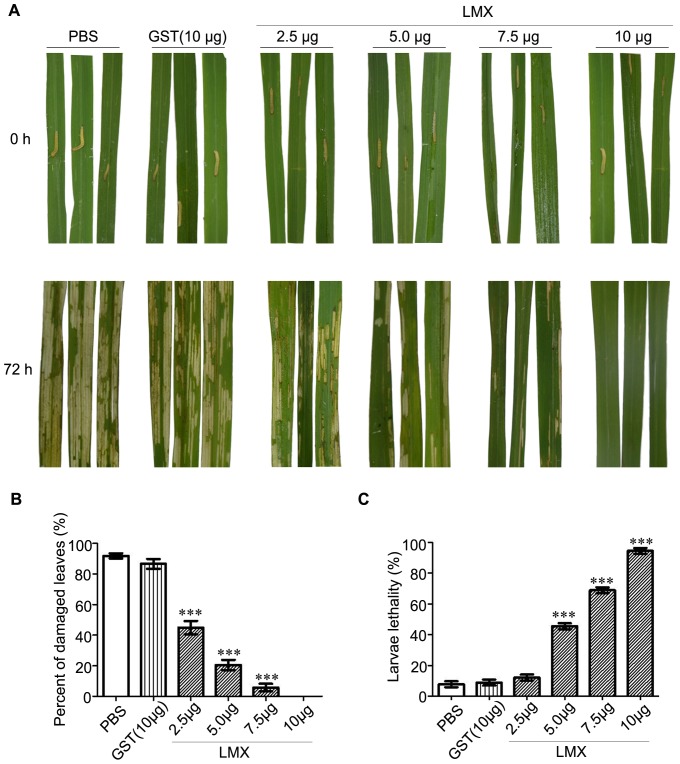
The LMX protein confers resistance to the rice leaf folder.
A. Damage to rice leaves daubed with 2.5 µg∼10 µg LMX fusion protein, caused by rice leaf folder. B. Ratio of the damaged leaf area to the whole leaf. C. Larvae lethality of the rice leaf folder fed with 2.5 µg∼10 µg bacterial-expressed LMX protein. For the control, the rice leaves were daubed with 1× PBS buffer and 10 µg GST tag protein. Pictures were taken and ratios of the damaged leaf area were measured after 72 h incubation with the rice leaf folder. Values are means ± SD. *** denotes 0.001 significant difference.